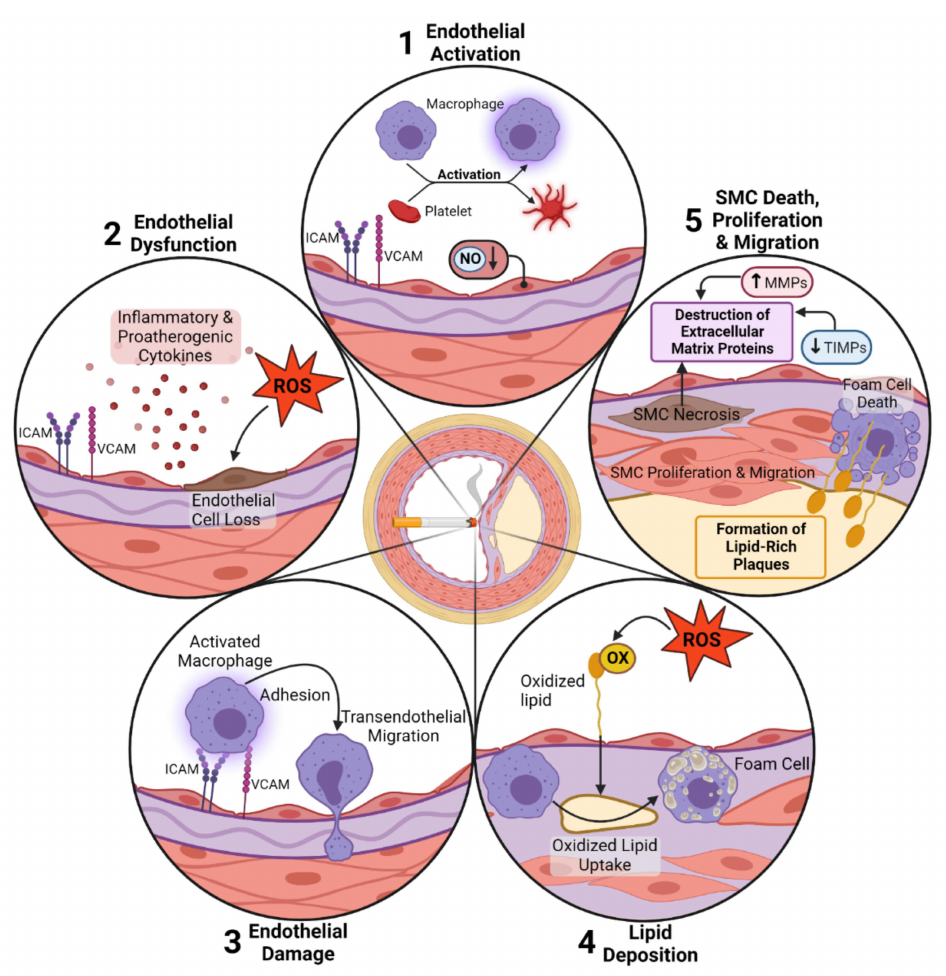
Figure 1. Schematic representation of smoking-induced signaling pathways in the vessel